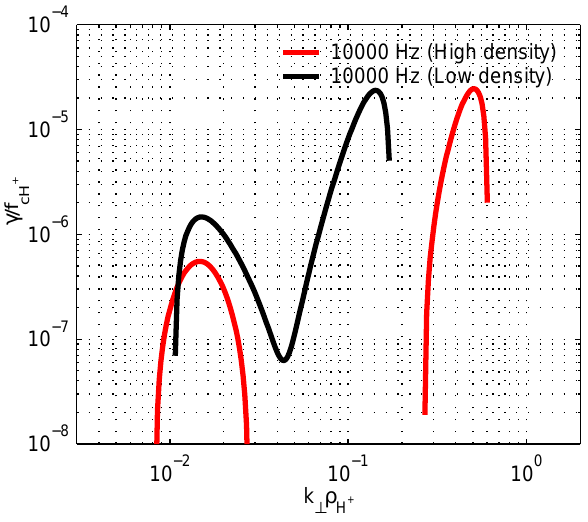
Fig. 11. The temporal growth rate versus k ⊥ ρ + H ( ρ H + = 7 m). In both the high (red lines) and low density (black line) cases there are two peaks in the growth rate, one at the perpendicular wave vector, where we believe most of the wave energy to be located, and one at larger k ⊥